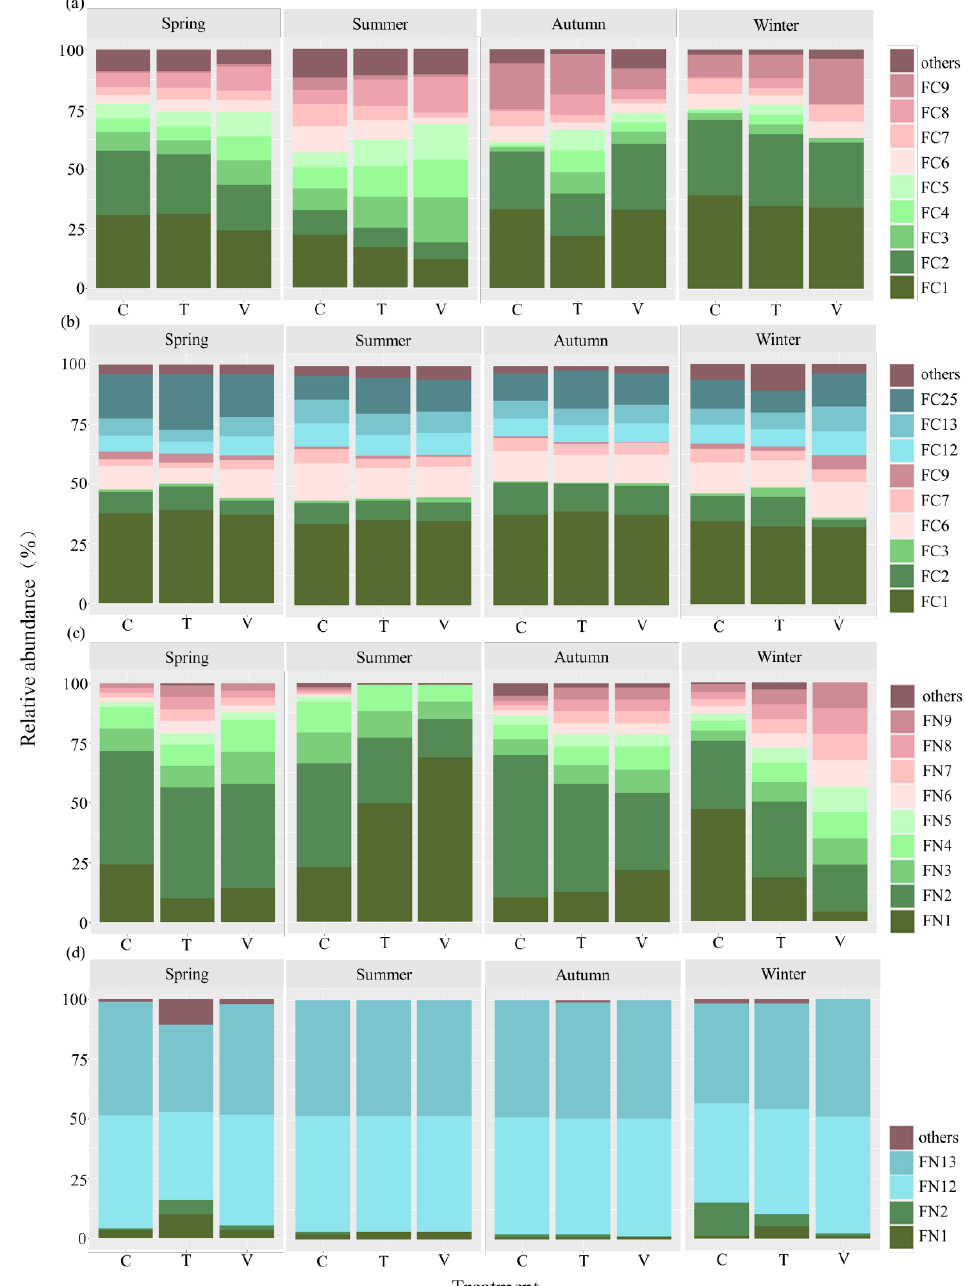
Figure 3. Relative functional abundance of bacteria related to carbon cycle in water column ( a ) and sediment ( b ), and relative functional abundance of bacteria related to the nitrogen cycle in water column ( c ) and sediment ( d ). Figure shows functional groups with more than 85% of the total functional abundance of bacteria. The carbon cycle in the figure is represented by FC1–FC25, and the specific functions are chemoheterotrophy (FC1), aerobic chemoheterotrophy (FC2), phototrophy (FC3), photoautotrophy (FC4), oxygenic photoautotrophy (FC5), methylotrophy (FC6), methanol oxidation (FC7), cyanobacteria (FC8), chloroplasts (FC9), hydrocarbon degradation (FC12), methanotrophy (FC13), and fermentation (FC25). The nitrogen cycle in the figure is represented by FN1-FN13, and the specific functions are nitrogen fixation (FN1), nitrate reduction (FN2), nitrate respiration (FN3), nitrogen respiration (FN4), nitrite respiration (FN5), nitrate denitrification (FN6), nitrite denitrification (FN7), nitrous oxide denitrification (FN8), denitrification (FN9), aerobic nitrite oxidation (FN12), and nitrification (FN13).